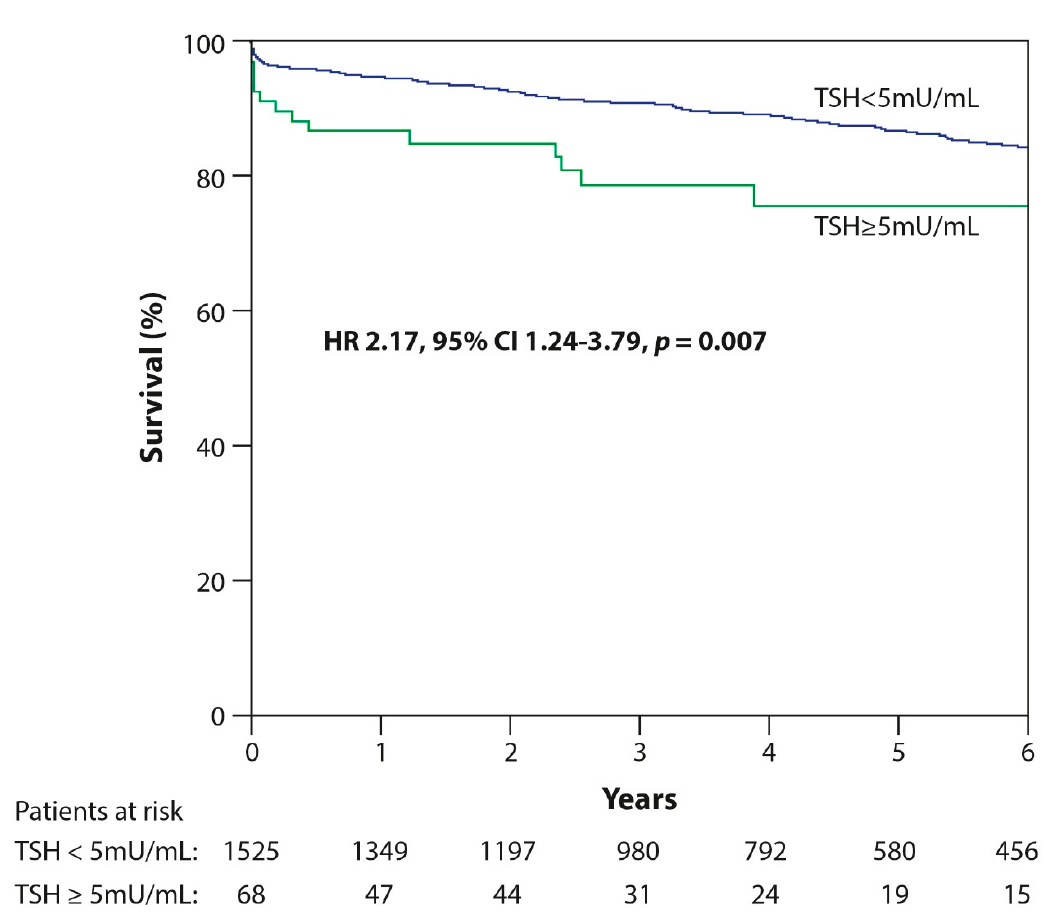
Figure 1. Kaplan–Meier Curve for Long-Term Survival of Patients with Subclinical Hypothyroidism vs. Euthyroid Patients. Green: patients with subclinical hypothyroidism (TSH > 5 mU / mL in the presence of a normal FT4 level); Blue: euthyroid patients (normal thyroid function, TSH < 5 mU / mL). TSH, thyroid-stimulating hormone; HR, hazard ratio; CI, confidence interval.